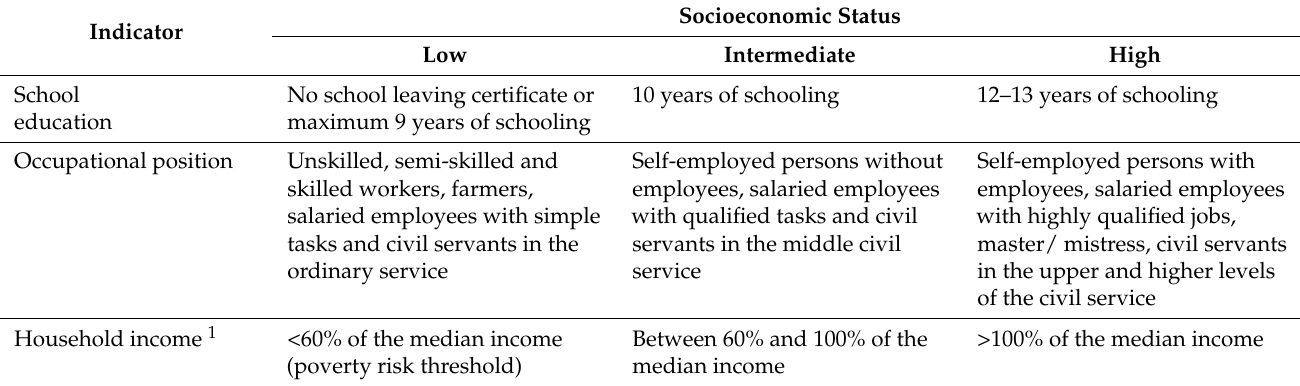
Table 1. Operationalization of the socioeconomic